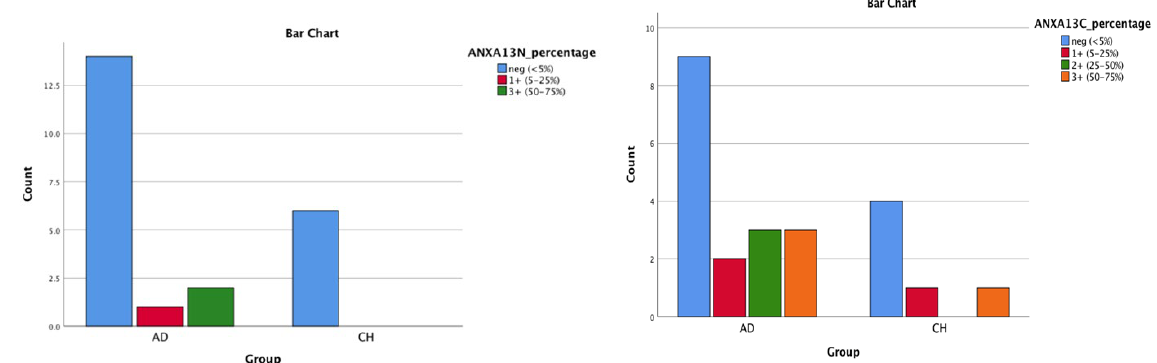
Fig. 6. Bar chart shows AnnexinA13 cytoplasmic positivity in PDA and